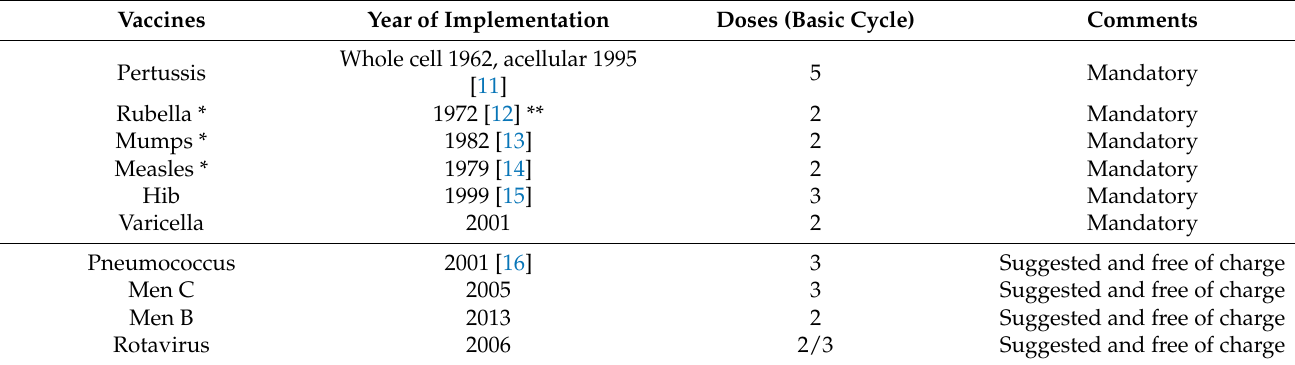
Table 2. Non mandatory vaccinations implemented in Italy according to different population groups and users. Measles, mumps, rubella (as MMR), varicella, pertussis and Hib became mandatory in 2017 according to a 2017 legislative decree [8]. The same legislative decree also recommends vaccination against meningococcus C (Men C), meningococcus B (Men B), pneumococcus and rotavirus in the same population 0–16 years of age; these vaccines are provided free of